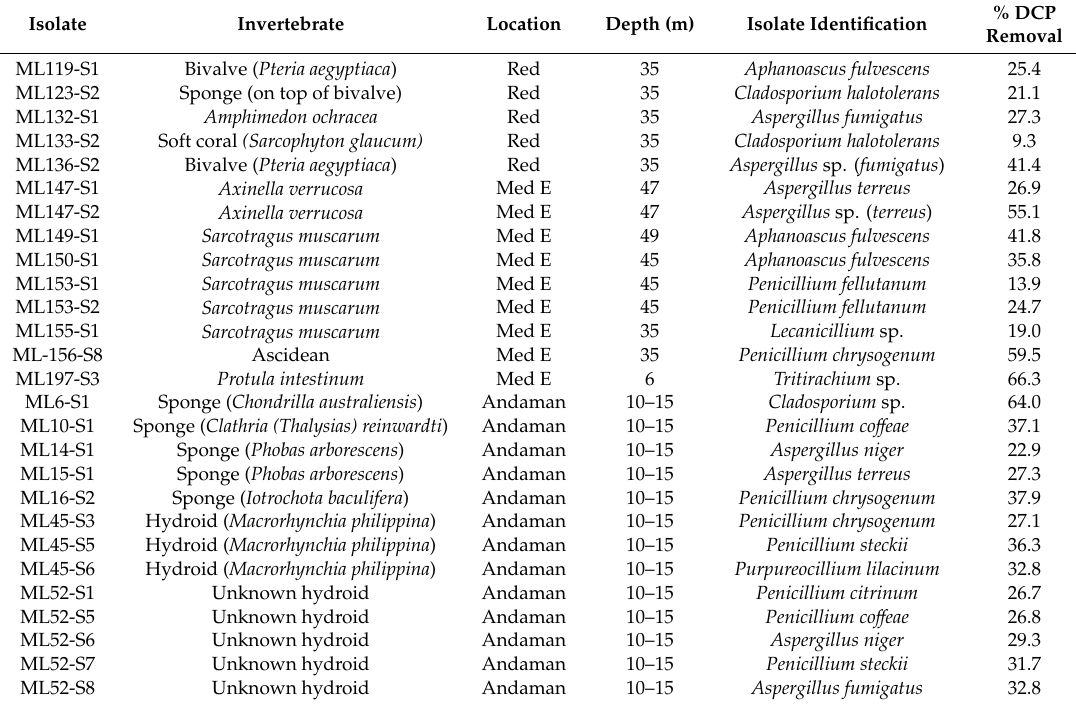
Table 1. Percentage of 2,4-dichlorophenol (2,4-DCP) removal in resting-cell reactions after 10 days for all isolated fungal strains, which were identified based on their internal transcribed spacer (ITS) sequence. Information (region and depth) about the invertebrate host of each strain is given. Locations: Red Sea (Red), east Mediterranean Sea (Med E), and Andaman Sea